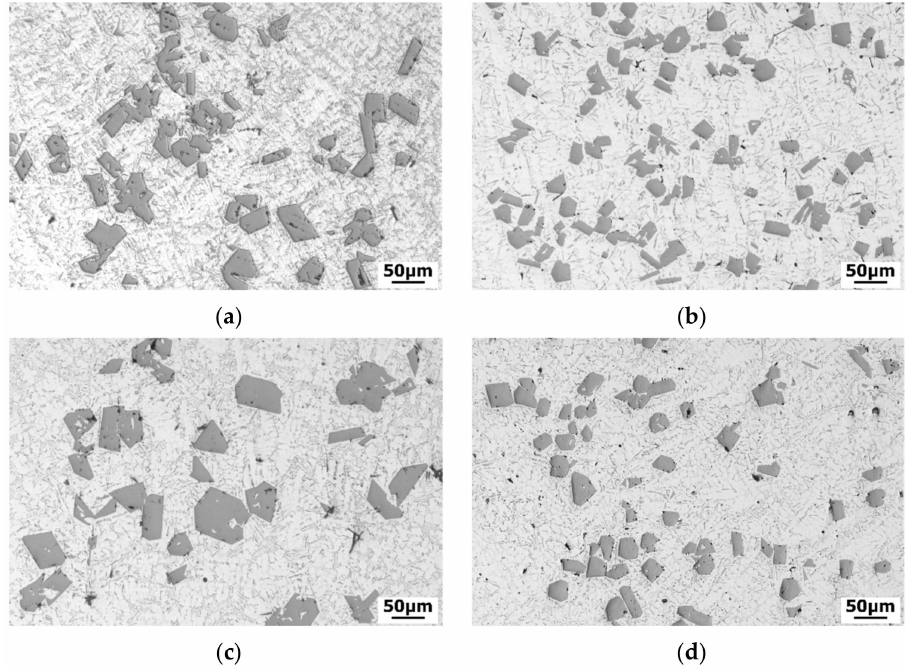
Figure 6. Optical micrographs showing the effect of Bi and P on primary silicon of ( a ) B390-0.05P-0.5Bi ( b ) B390-0.1P-0.5Bi ( c ) B390-0.05P-1.0Bi and ( d )